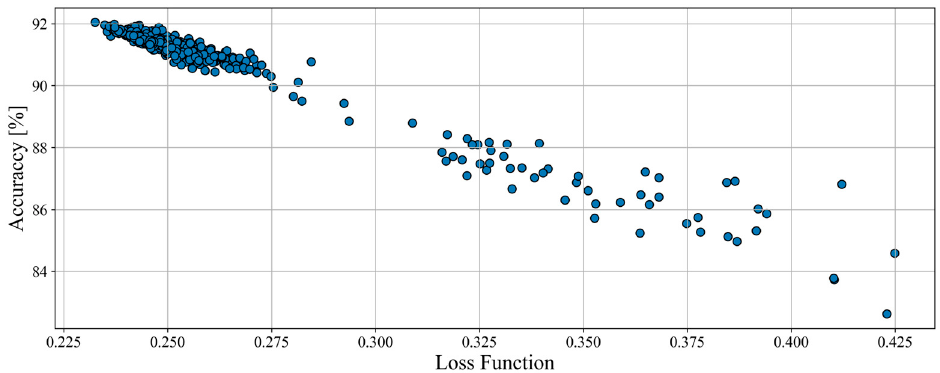
Figure 4. Accuracy and value of loss function of structures examined during the structure optimi- zation process for haul trucks.